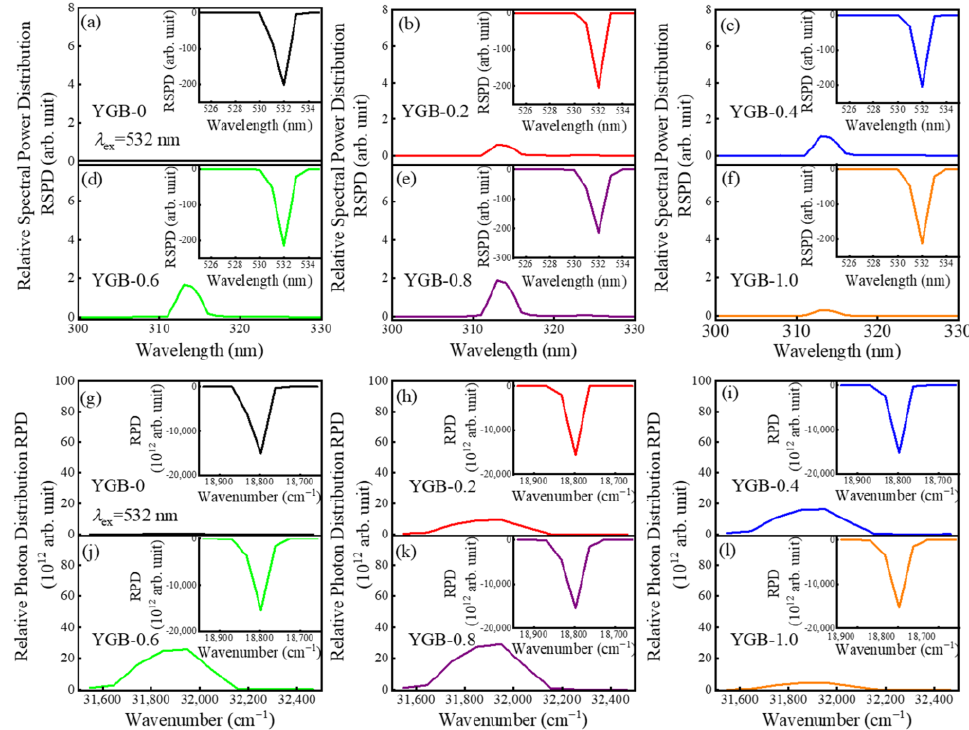
Figure 8. ( a – f ) Relative spectral power distributions and ( g – l ) relative photon distributions of Y 0 . 9 (Gd x Bi 1 − x ) 0 . 1 BO 3 (x = 0, 0.2, 0.4, 0.6, 0.8 and 1.0) phosphors annealed at 800 °C under the 532 nm excitation.